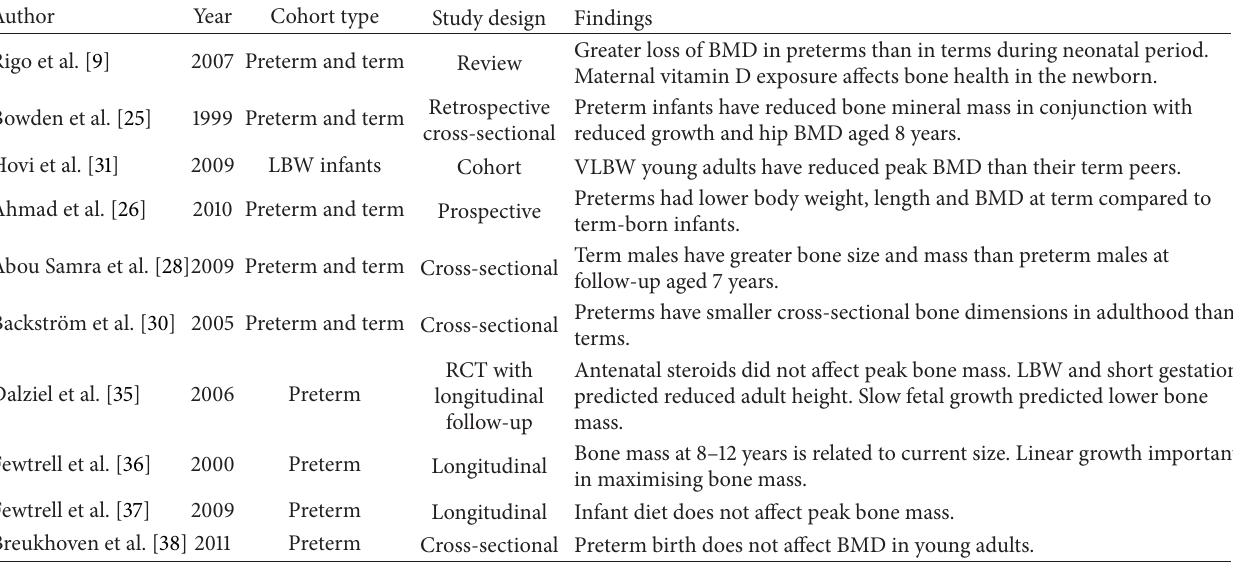
Table 1: Summary of key papers on BMD and osteoporosis after preterm